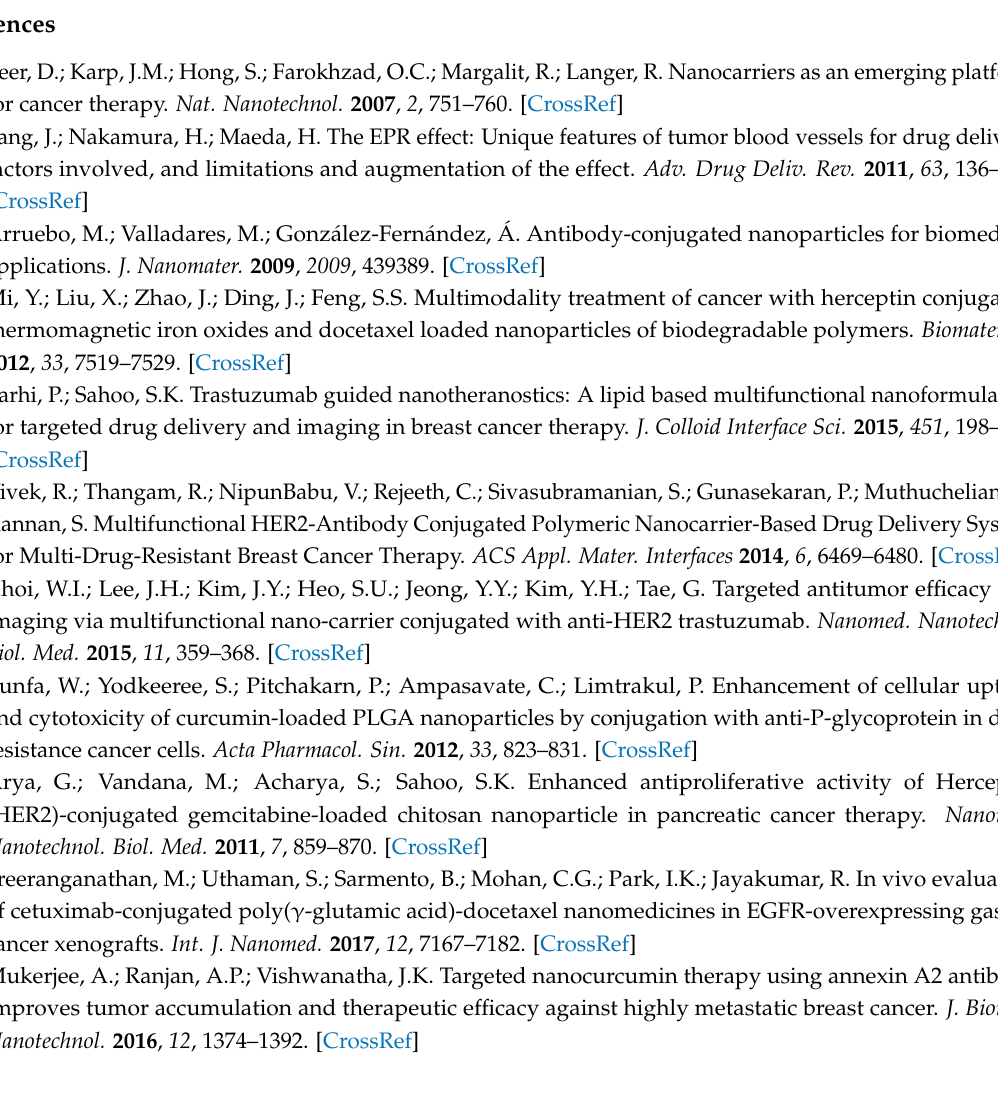
Figure S1: MM cell lines express high levels of CD38, Figure S2: Characterization of U266-luc